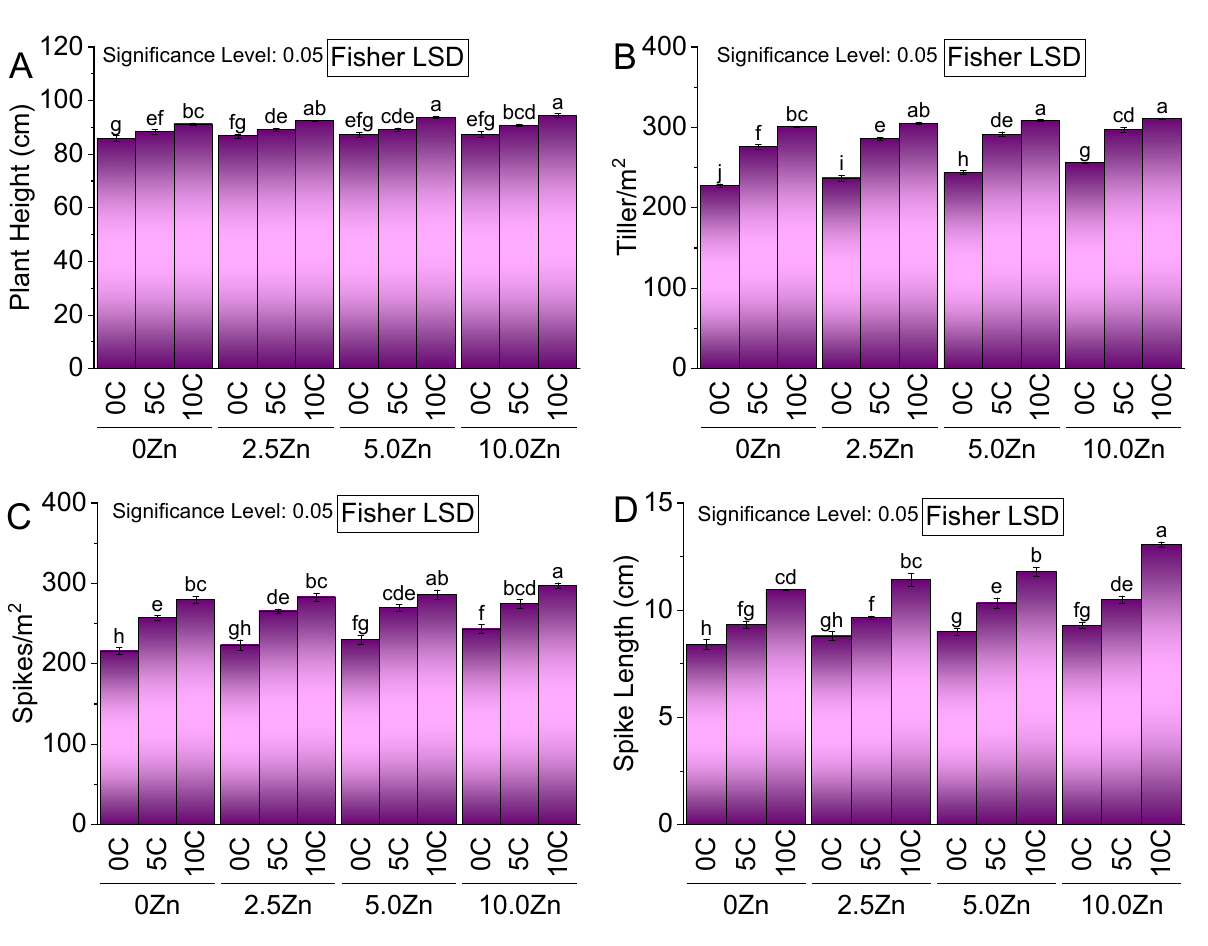
Figure 1. Impact of various zinc application amounts (0, 2.5, 5.0 and 10.0 kg/ha) with different levels of compost (0, 5 and 10 t/ha) on plant height ( A ), tillers/m 2 ( B ), spikes/m 2 ( C ) and spike length ( D ) of wheat. Different letters over bars represent significant changes at p ≤ 0.05 using Fisher’s LSD test.